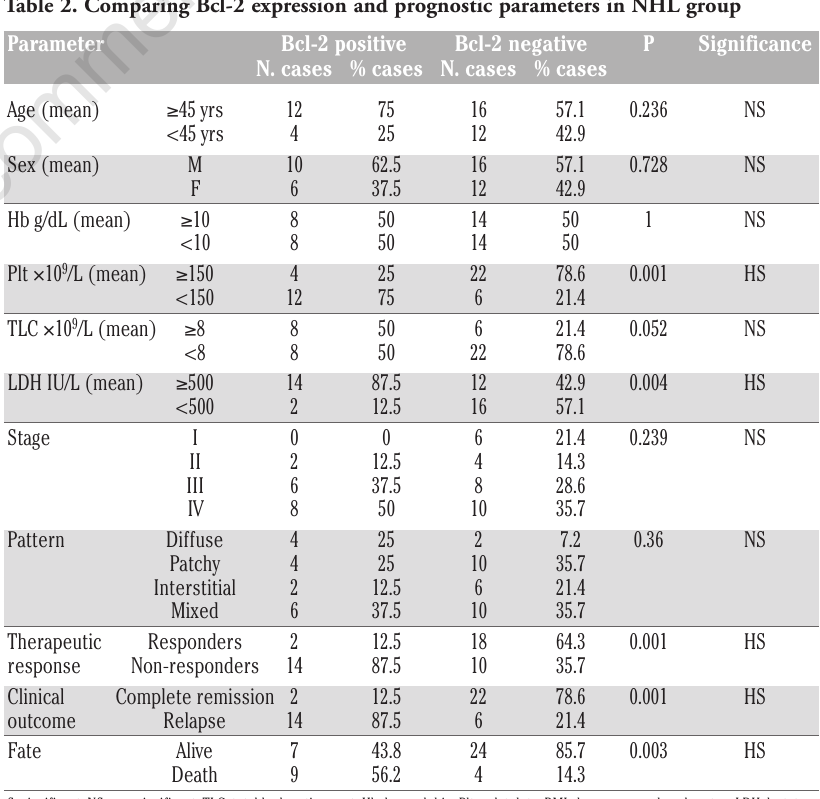
Table 2. Comparing Bcl-2 expression and prognostic parameters in NHL group